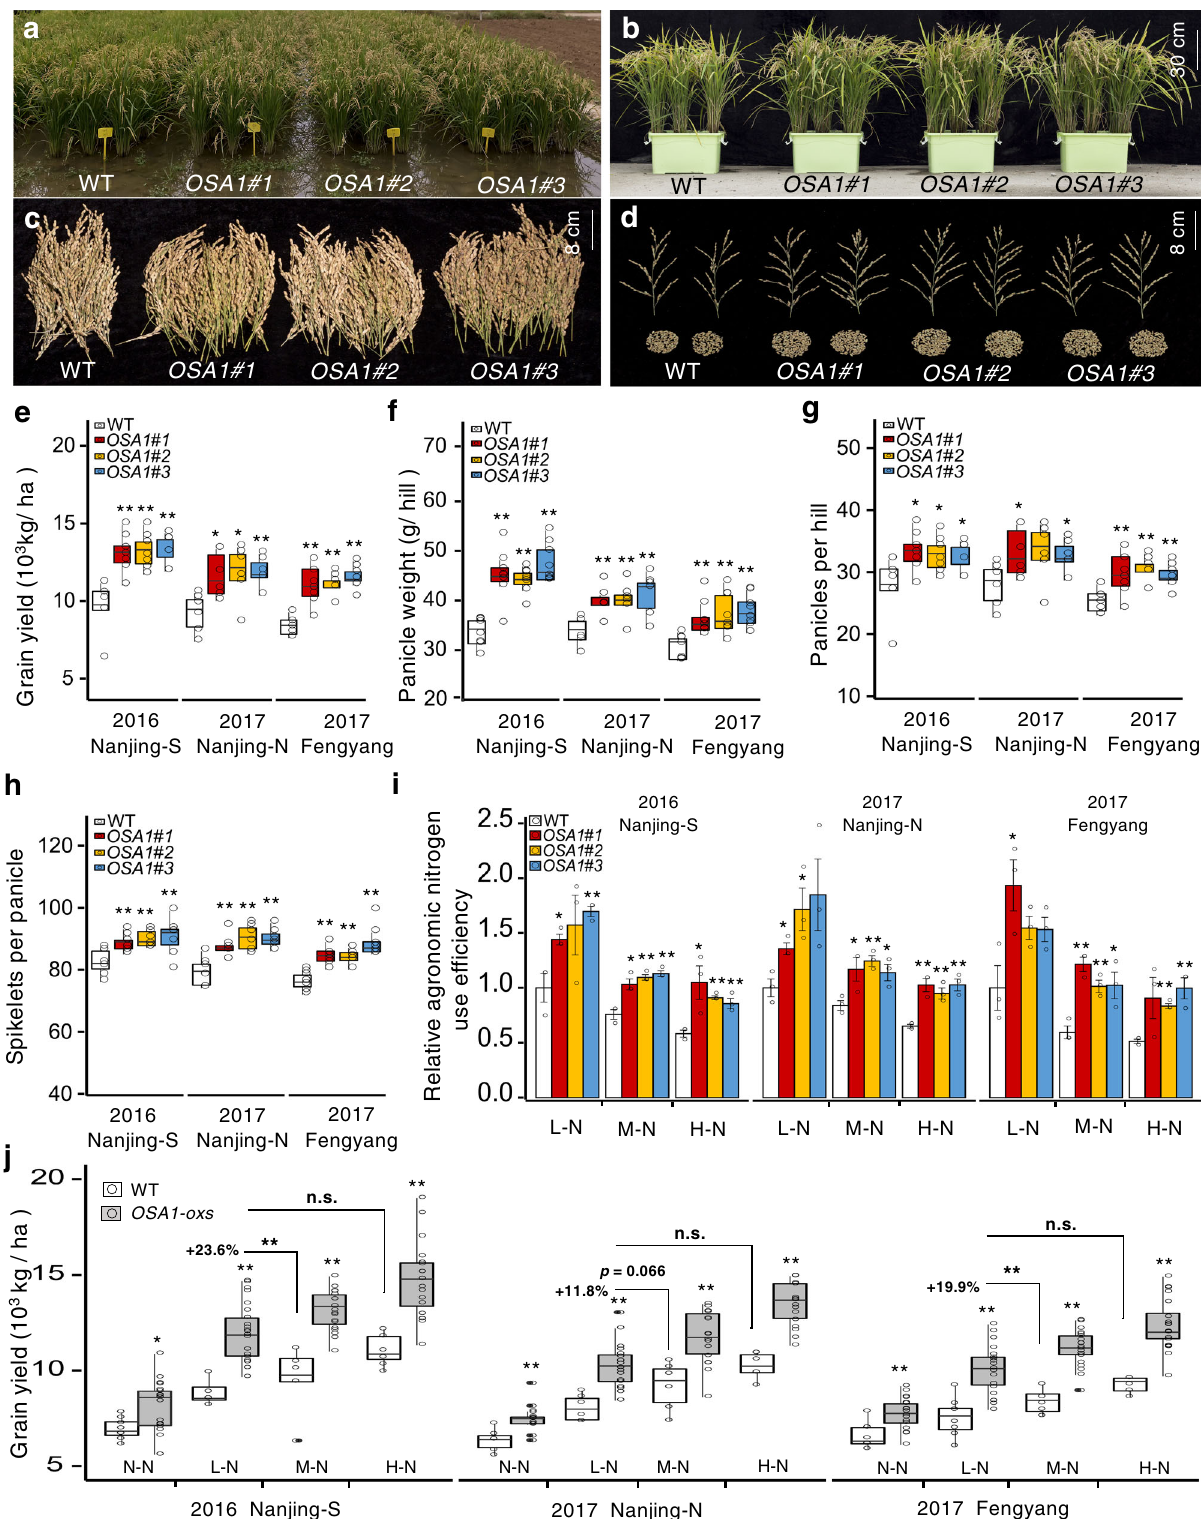
pumped excessive H + out of root cells during NH 4 + assimilation (Supplementary Fig. 12). Through this feedback, OSA1 -ox rice absorbs and uses NH 4 + more ef fi ciently than do WT plants (Figs. 2f – g and 3f – g), which is important for NUE